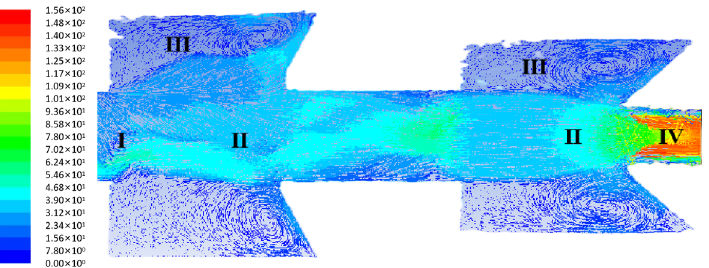
Figure 5. Watershed distribution of the primary and secondary oscillating cavities.